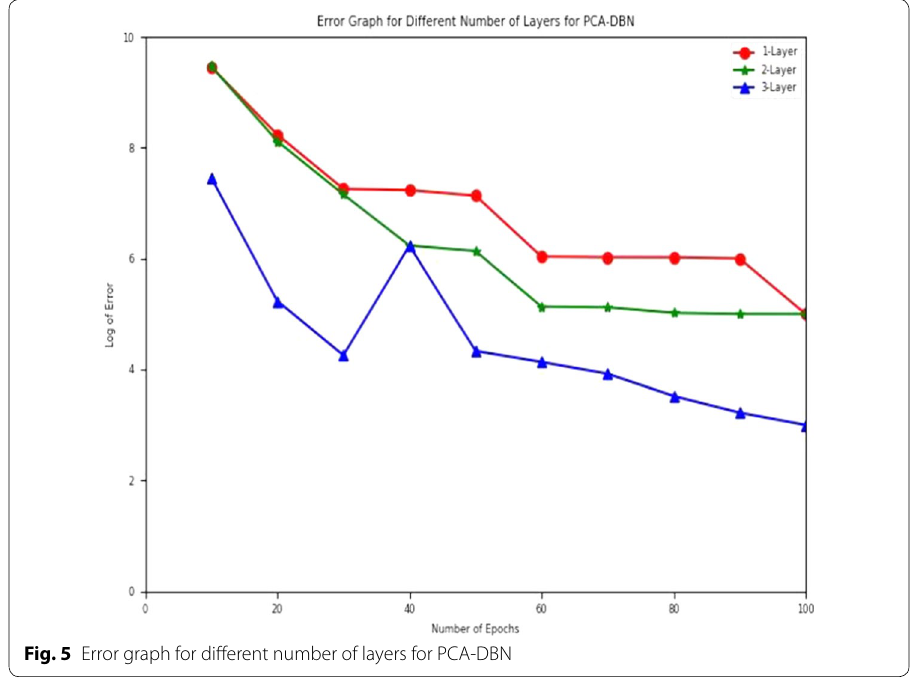
Fig. 5 Error graph for different number of layers for PCA-DBN